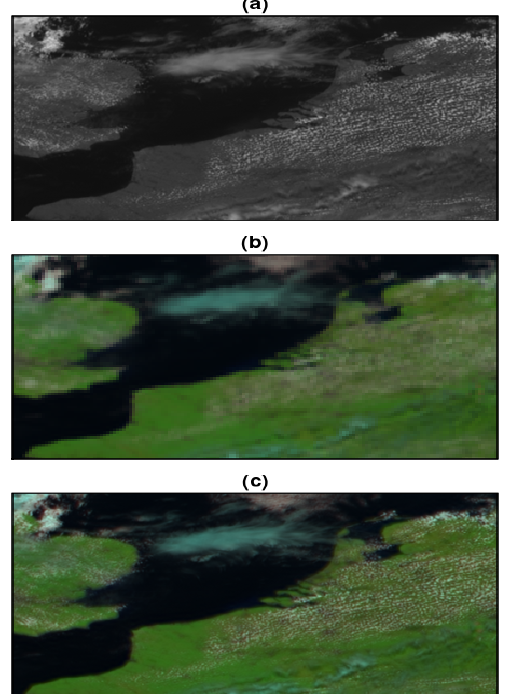
Fig. 4. Example output of the downscaling algorithm in compar- ison to standard SEVIRI images, based on a scene from 36 June 2008 of England, the British channel, north-eastern France, Bel- gium and the Netherlands. Panel (a) shows the HRV reflectance in grey levels, while (b) shows the day natural colors RGB compos- ite of Lensky and Rosenfeld (2008) at standard SEVIRI resolution. Panel (c) is based on the downscaled 0.6 and 0.8µm reflectances at HRV channel resolution, combined with an 1.6µm image obtained by trigonometric